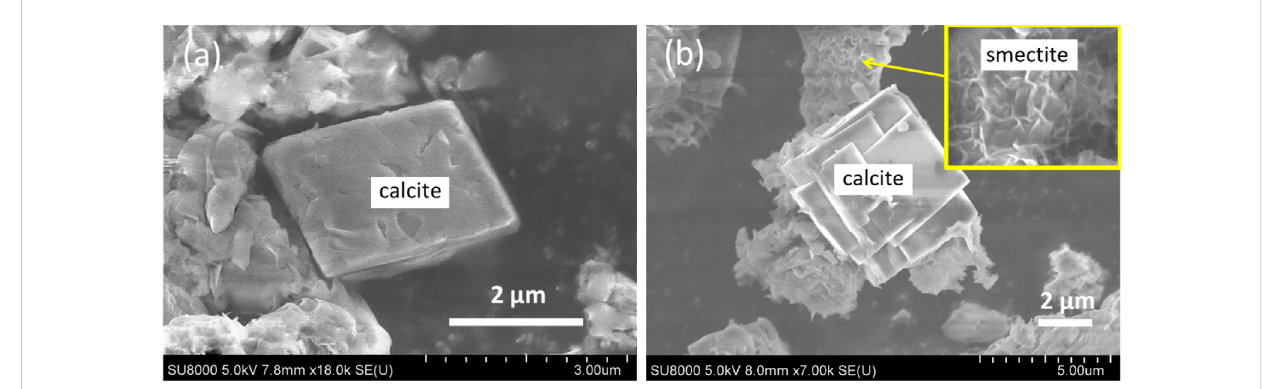
FIGURE 4 SEM images of solid samples collected after reacting in 0.5 mol/L NaHCO 3 solution for (A) 5 days and (B) 10 days.